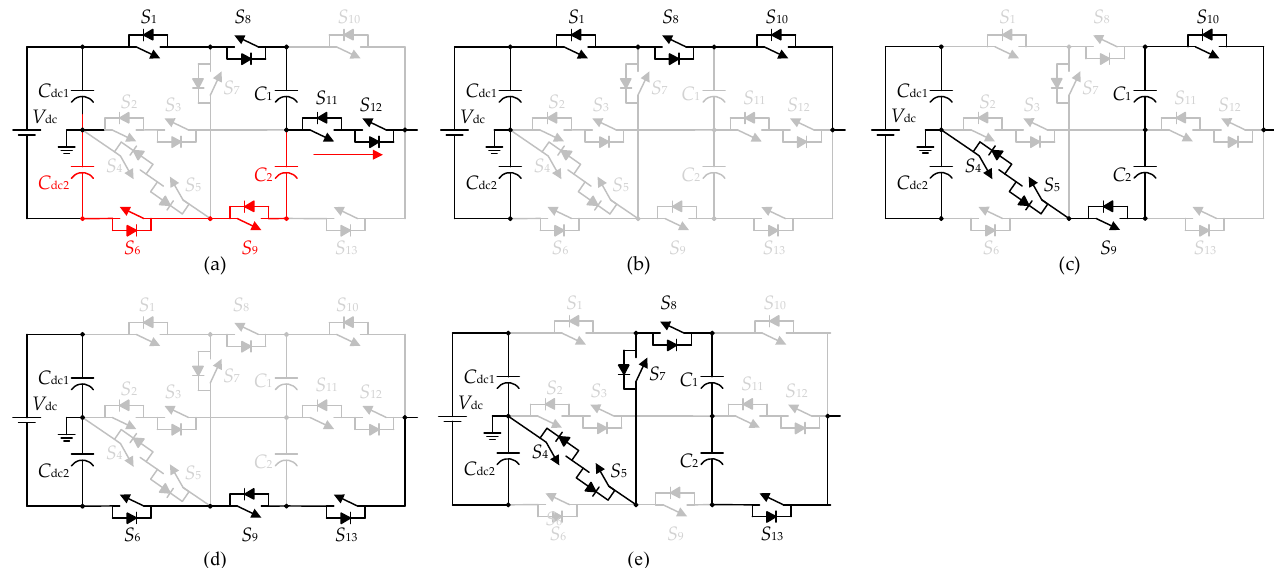
Figure 5. Redundant switching states of the proposed three-phase SCMLI structure at ( a ) 0 V, ( b ) 0.5 V dc , ( c ) V dc , ( d ) − 0.5 V dc , and ( e ) − V dc .